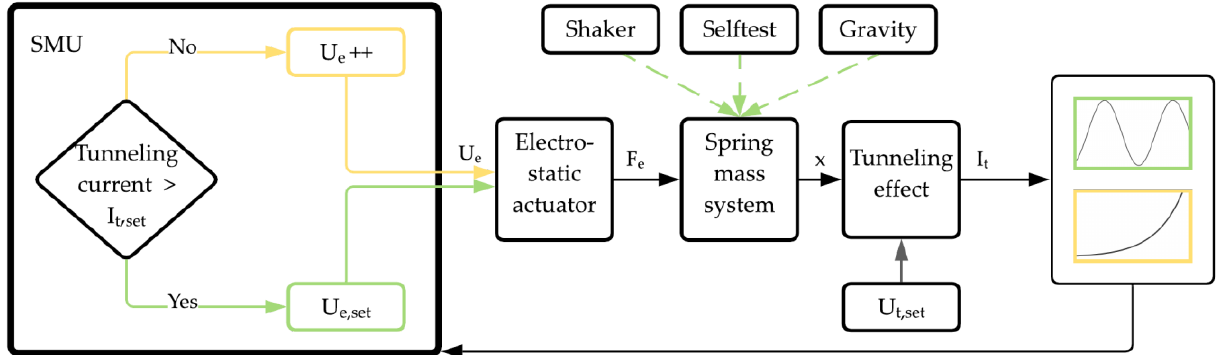
Figure 3. Diagram of the sensor system with the respective output variables. 𝑈 𝑒 = actuator voltage, 𝐹 𝑒 = electrostatic force, 𝑥 = deflection, 𝐼 𝑡 = tunneling current.